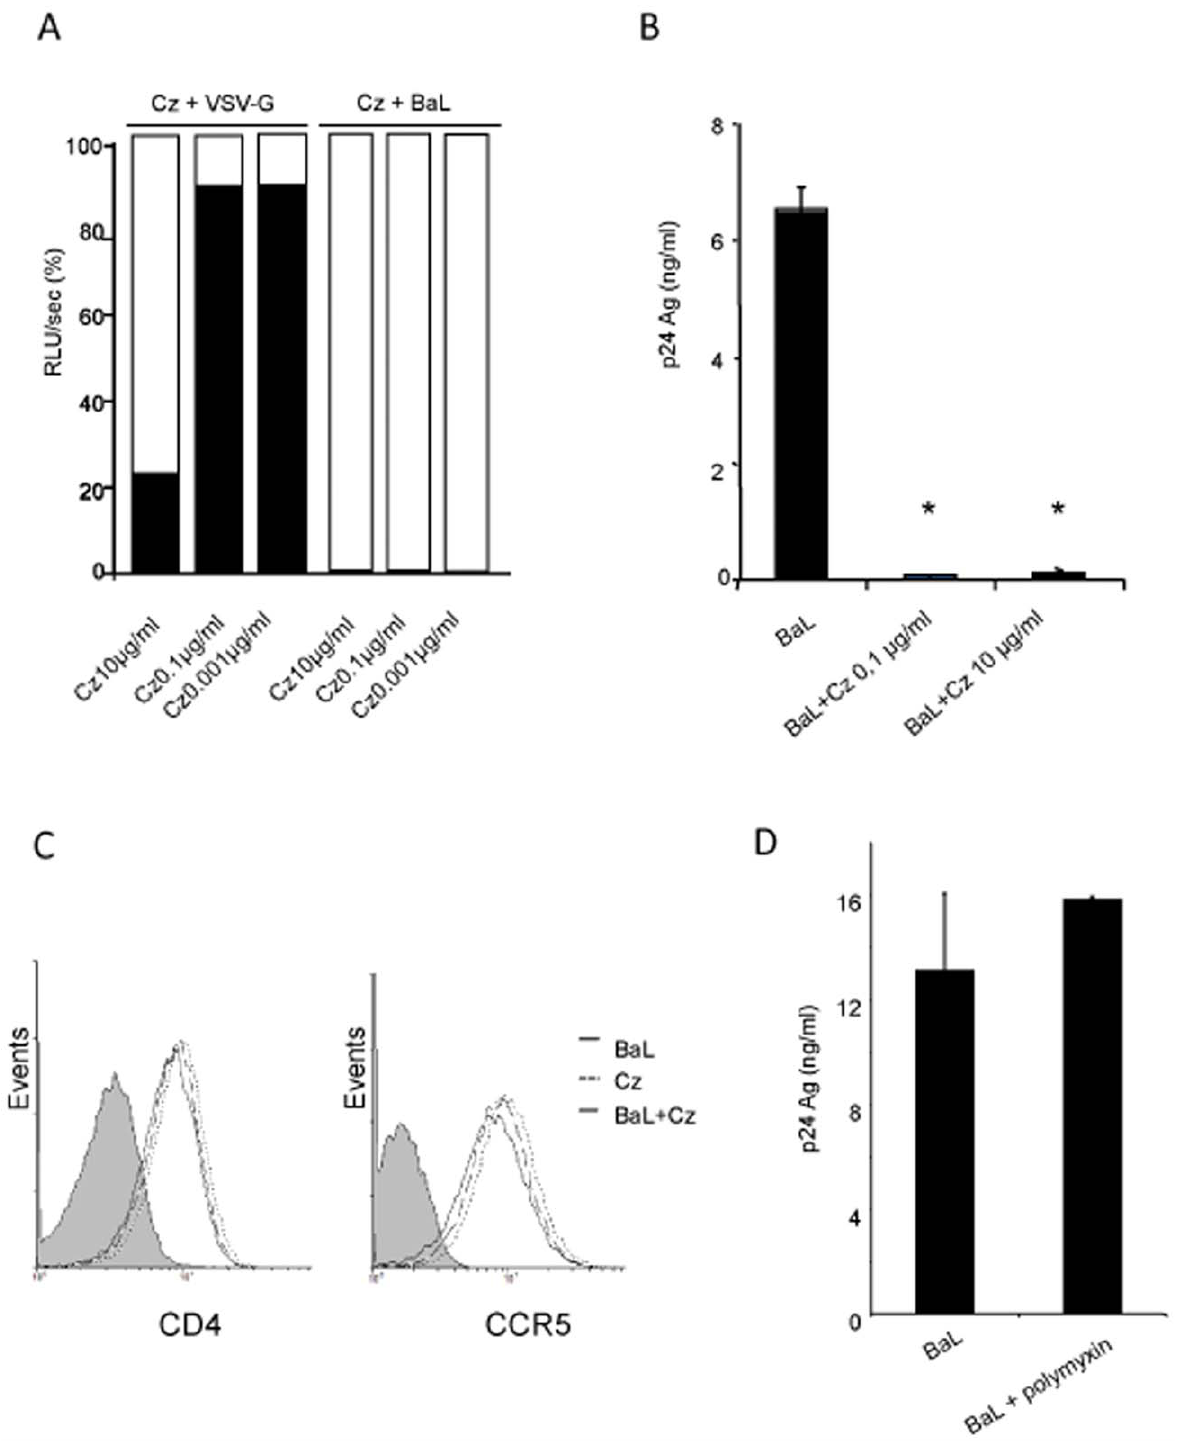
Figure 8. Implication of the major antigen cruzipain in the inhibition of HIV-1 replication cycle. ( A ) Cells were infected with either VSV-G or BaL pseudotyped viruses in the presence of 0.001; 0.1 and 10 m g/ml of cruzipain (Cz). Luciferase activity was measured in cell lysates 96 h p.i. Results are expressed as relative light units per second (RLU/sec), presented as a percentage relative to the control (100%), where the histogram in white corresponds to the percentage of infection with the respective control virus and the histogram in black corresponds to the percentage of infection in the presence of the parasite. A representative experiment of 3 is shown. ( B ) Production of p24 antigen at day 8 p.i. in cells treated with 0.1 and 10 m g/ml of cruzipain. Results are expressed as mean 6 SD of triplicates of infection and a representative experiment of 3 others is shown. ( C ) Influence of cruzipain on cell surface expression of CD4 and CCR5 after overnight infection in the presence of 0.1 m g/ml of cruzipain. Histograms in grey correspond to isotype control. Results are representative of at least 3 independent experiments. * p , 0.01. ( D ) Cells were infected with BaL isolate in the presence or absence of polymyxin, and p24 antigen production was measured at day 8 p.i. Results are expressed as mean 6 SD of triplicates of infection and a representative experiment of 3 is shown.